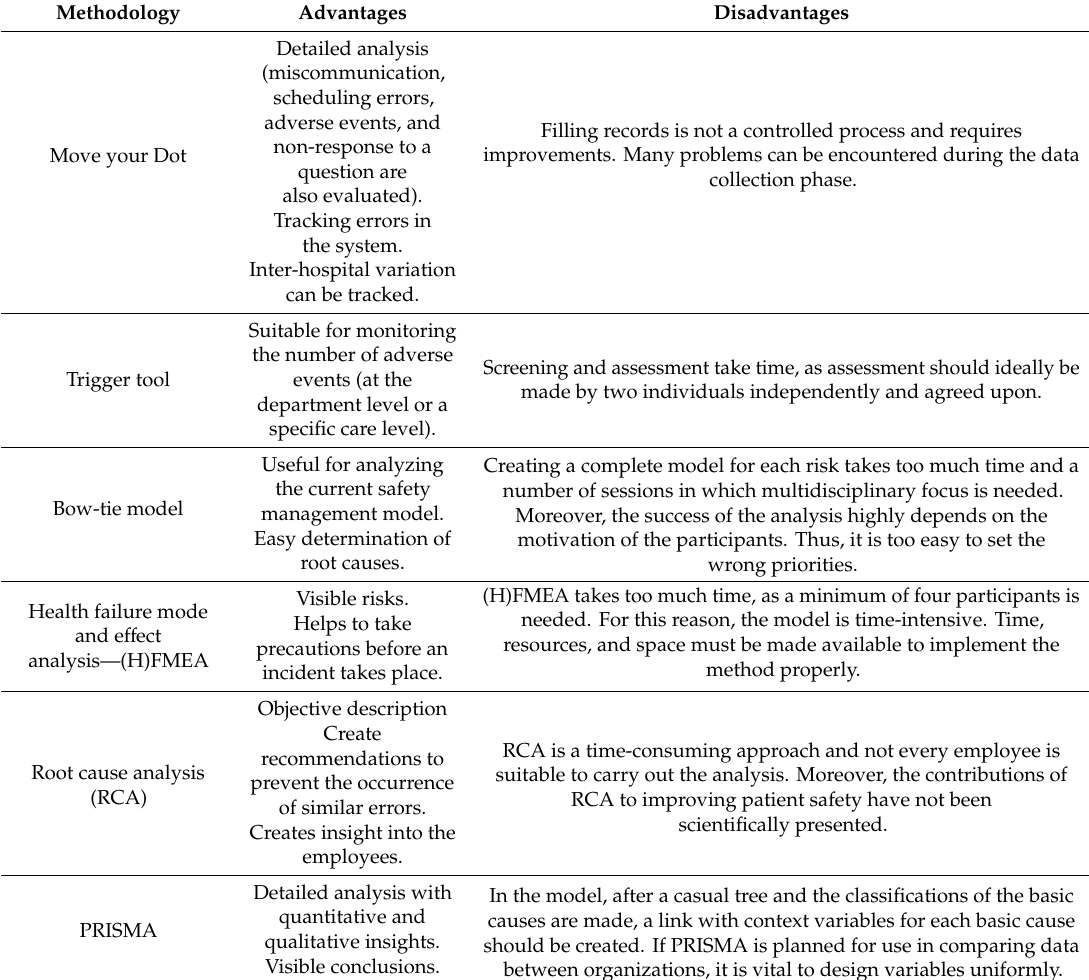
Table 1. Summary of the examined